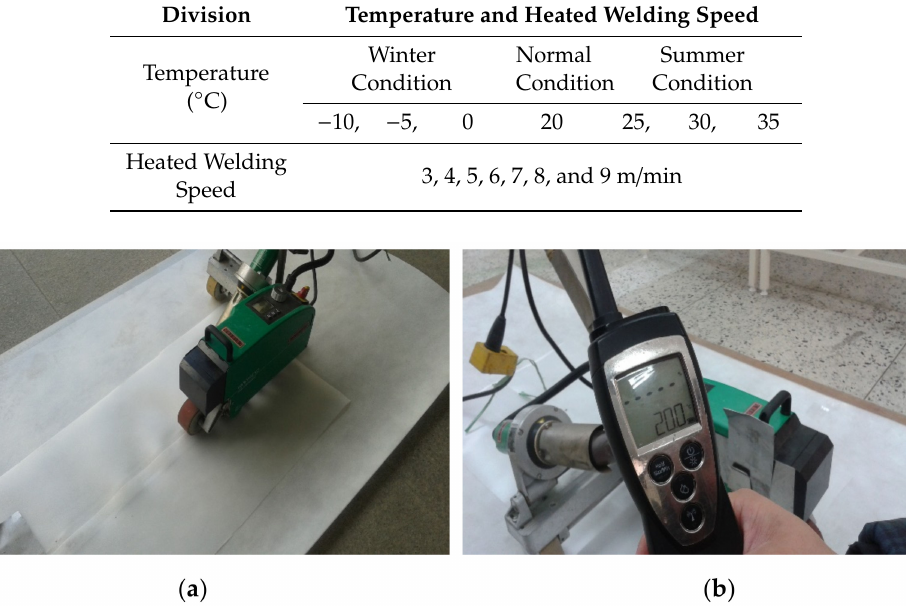
Figure 1. Status of hot air welding construction: ( a ) hot air welding construction; and ( b ) measurement of external